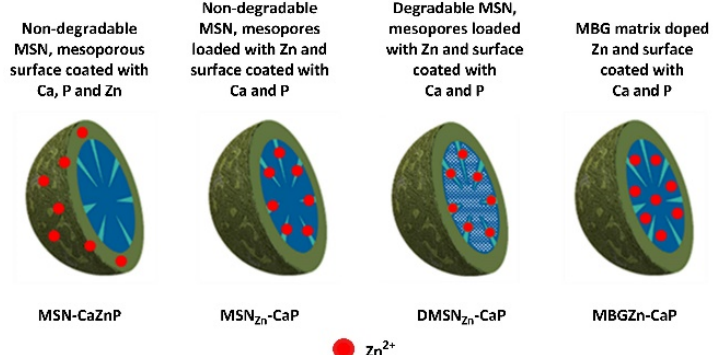
Scheme 1. Schematic representation of synthesized nanoparticles and location of Si, Ca, P and Zn ions within the nanoparticles; blue represents Si network, green represents calcium phosphate layer, and red represents Zn